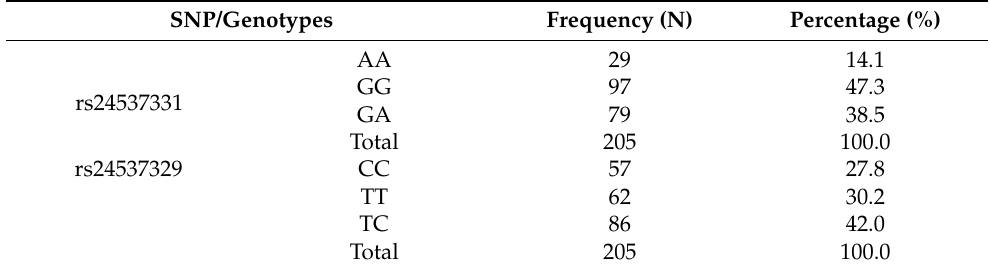
Table 1. Genotypic and allele frequencies of the SNPs rs24537331 and rs24537329 in the canine HER2